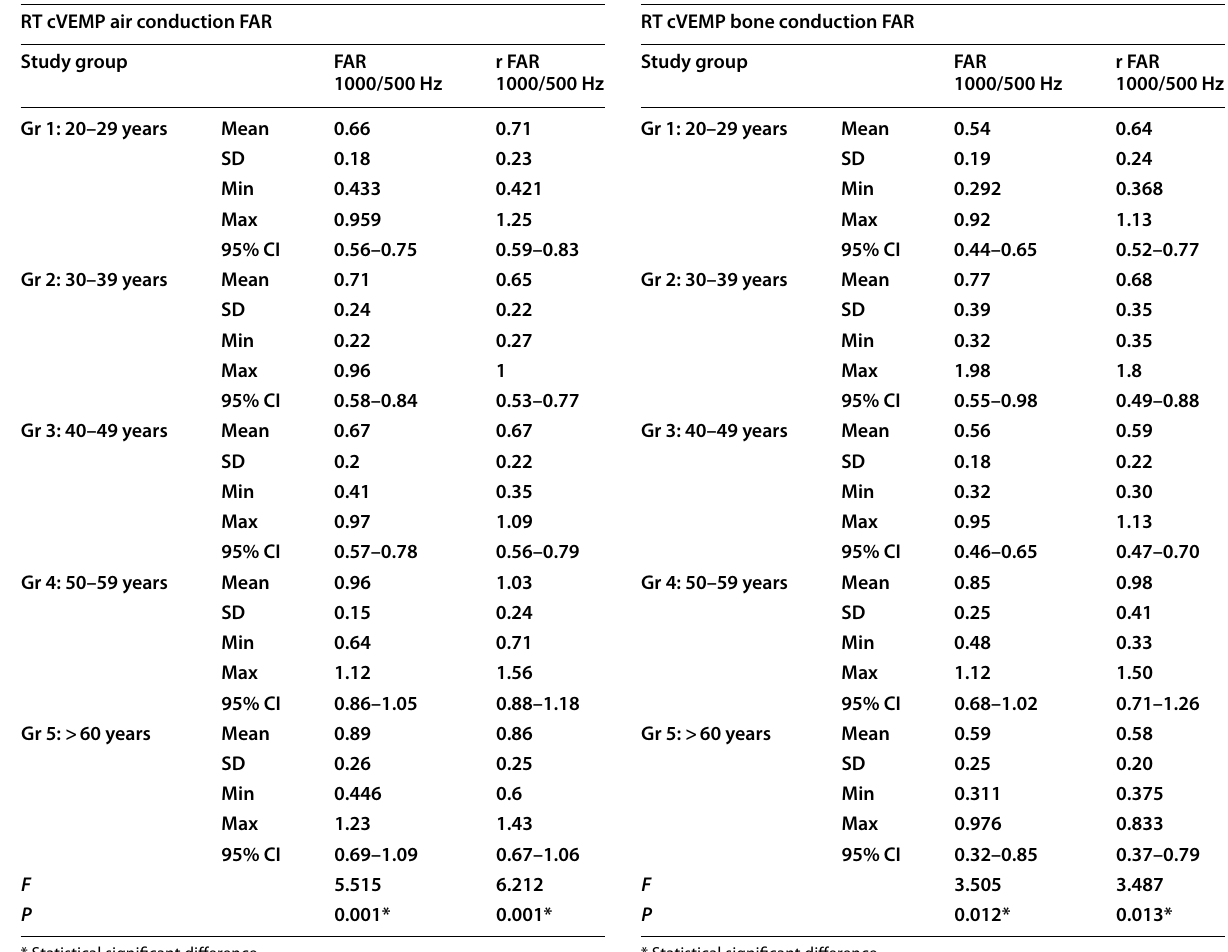
Table 3 Comparison among the 5 studied groups regarding Table 4 Comparison among the 5 studied groups